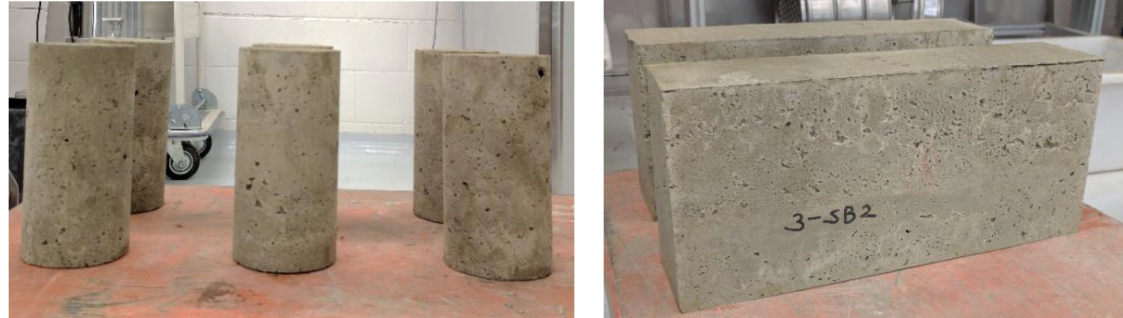
Figure 12. Cylinder and block specimens of C-S mix.